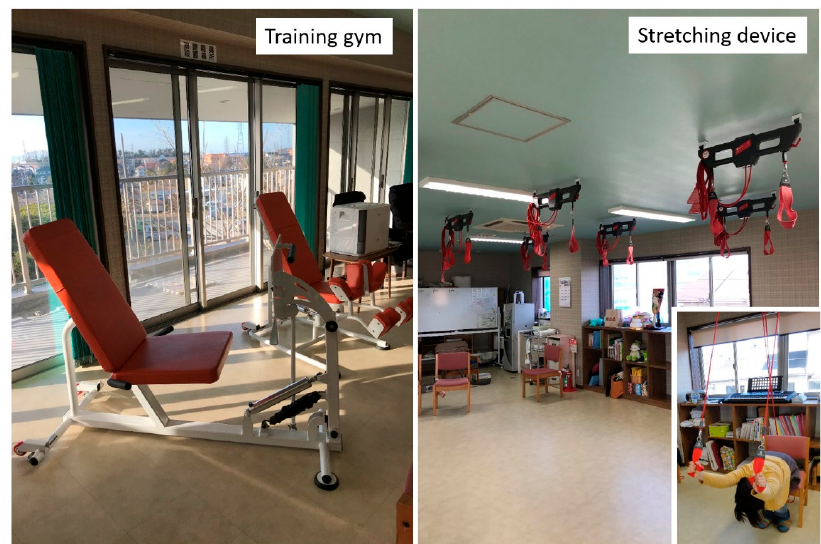
Figure 15. Stretching devices (Redcord AS 2014) and hydraulic training gym (Zaoba Corporation 2012) in Sawayaka Town.